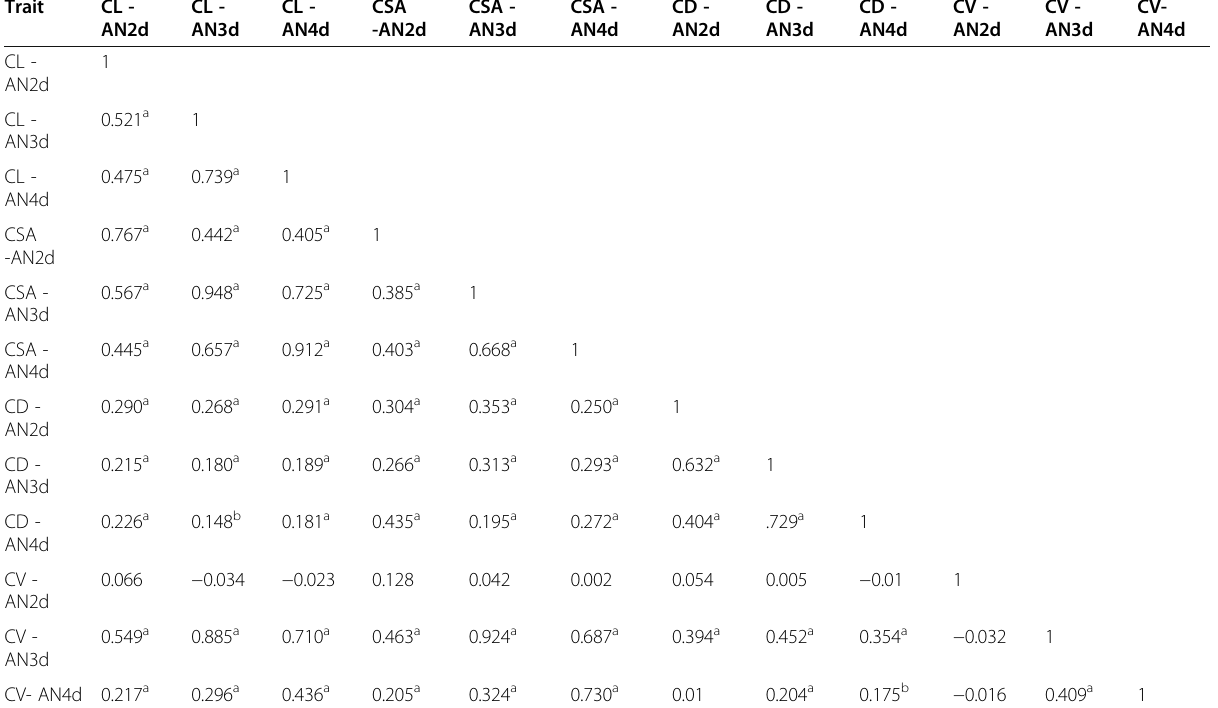
Table 2 Correlation analysis of coleoptile phenotpye